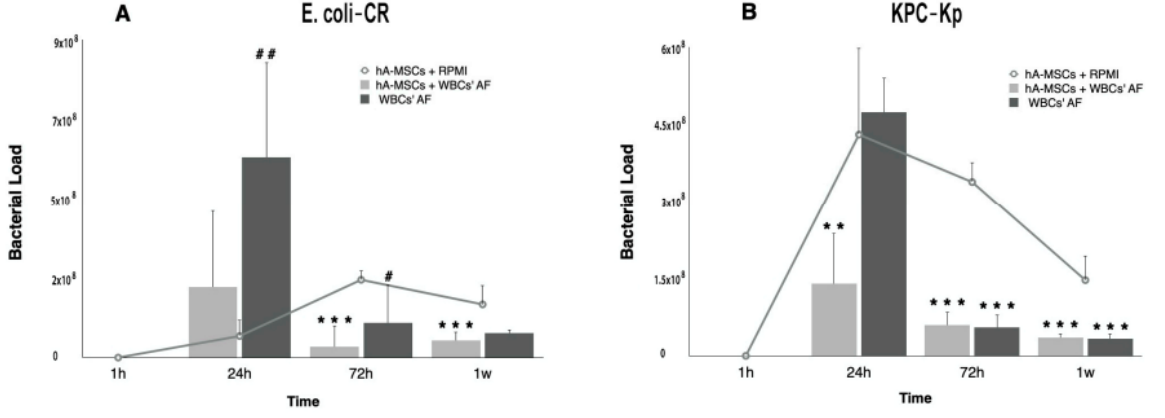
Figure 2. The effects of hA-MSCs on the bacterial load of AF infected with E. coli-CR ( A ) and KPC- Kp ( B ). The bacterial proliferation after 1 h, 24 h, 72 h, and 1 week of exposure, compared